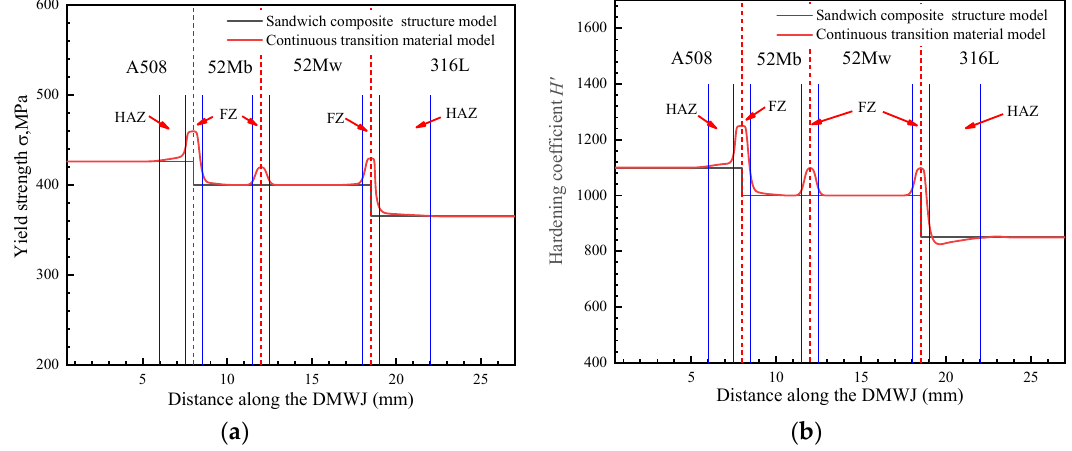
Figure 3. Distributions of ( a ) yield strength and ( b ) hardening coefficient along the DMWJ.